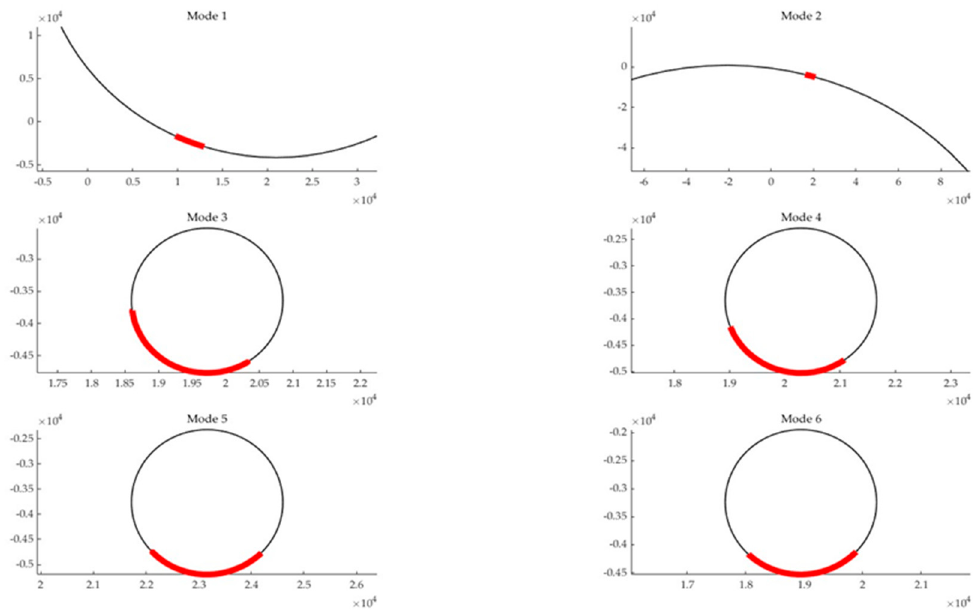
Figure 6. Fitting circle diagram of a track on cement ground.